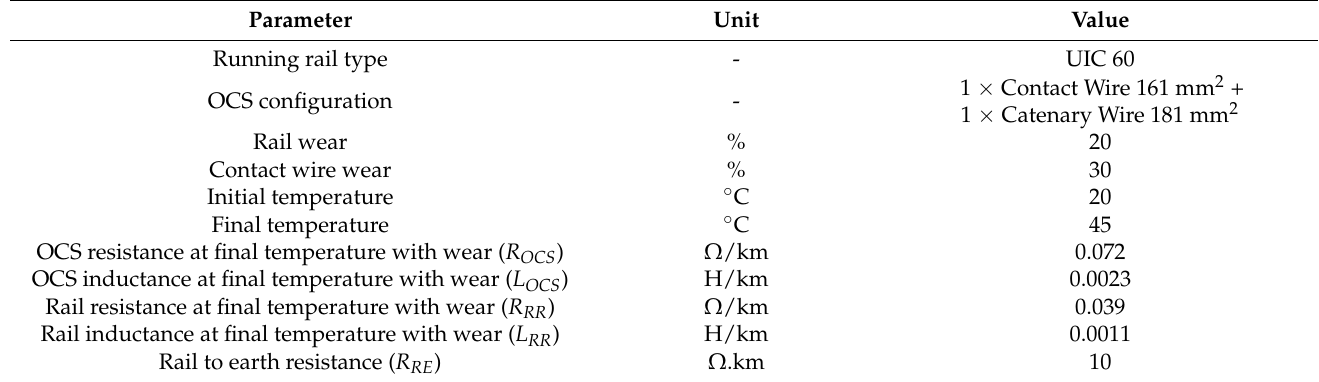
Table 5. OCS and running rail input parameters.